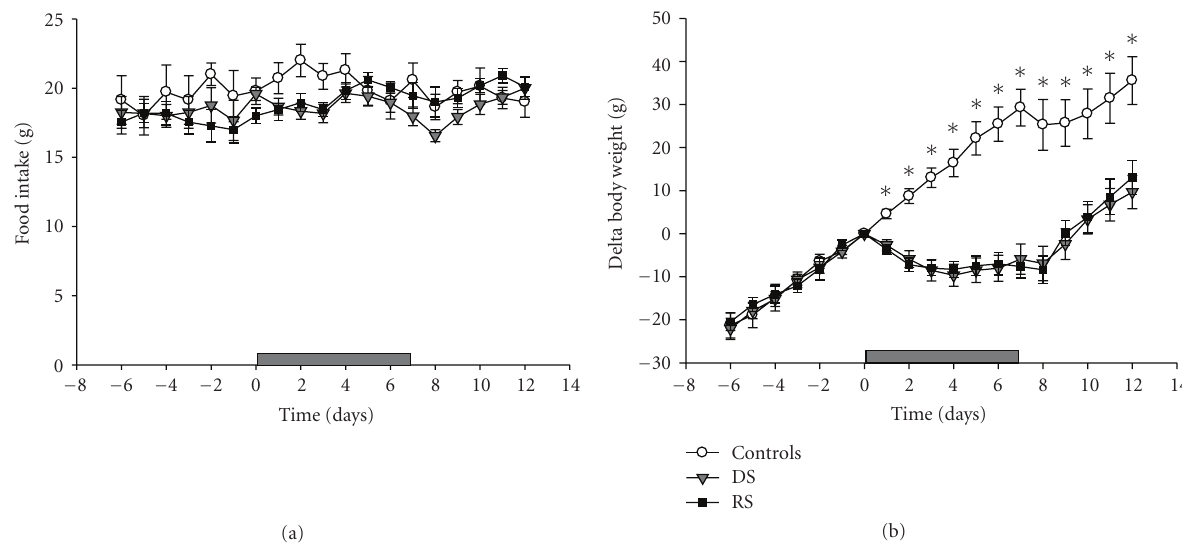
Figure 2: Average daily food intake (a) and body weight (b) in the baseline, experimental, and recovery phase of the experiment for RS ( n = 11), DS ( n = 12), and control ( n = 7) animals. The horizontal grey bars at the bottom of the graphs represent the 8-day period of RS or DS. Data are average values ± SEM. Asterisks indicate a significant di ff erence between sleep disturbed (DS and RS) and control animals ( ∗ P <